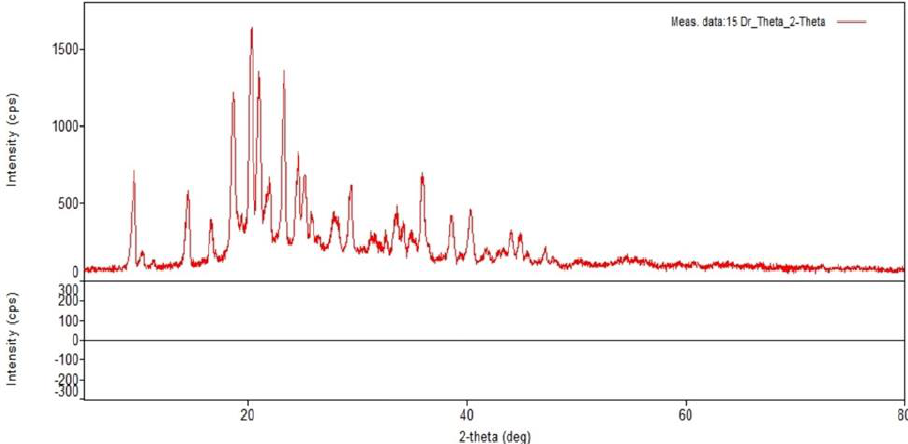
Figure 4. XRD analysis of lyophilized amikacin sulfate loaded dextran nanoparticles (LADNP). The diffractogram was obtained at 2 θ in the range 2°–80°.